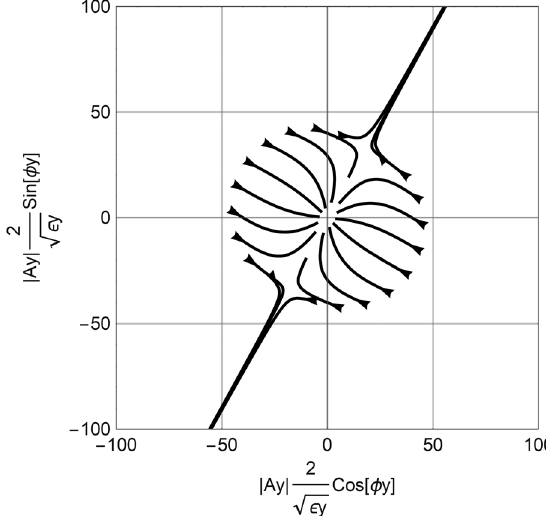
19. Evolution of the average particle trajectories, solu- tion of Eqs. (49) and (50) with the same initial amplitude and different initial phases. Initial amplitude corresponds 0 Þ ¼ 40 σ to y 0 ð φ . y ¼ y